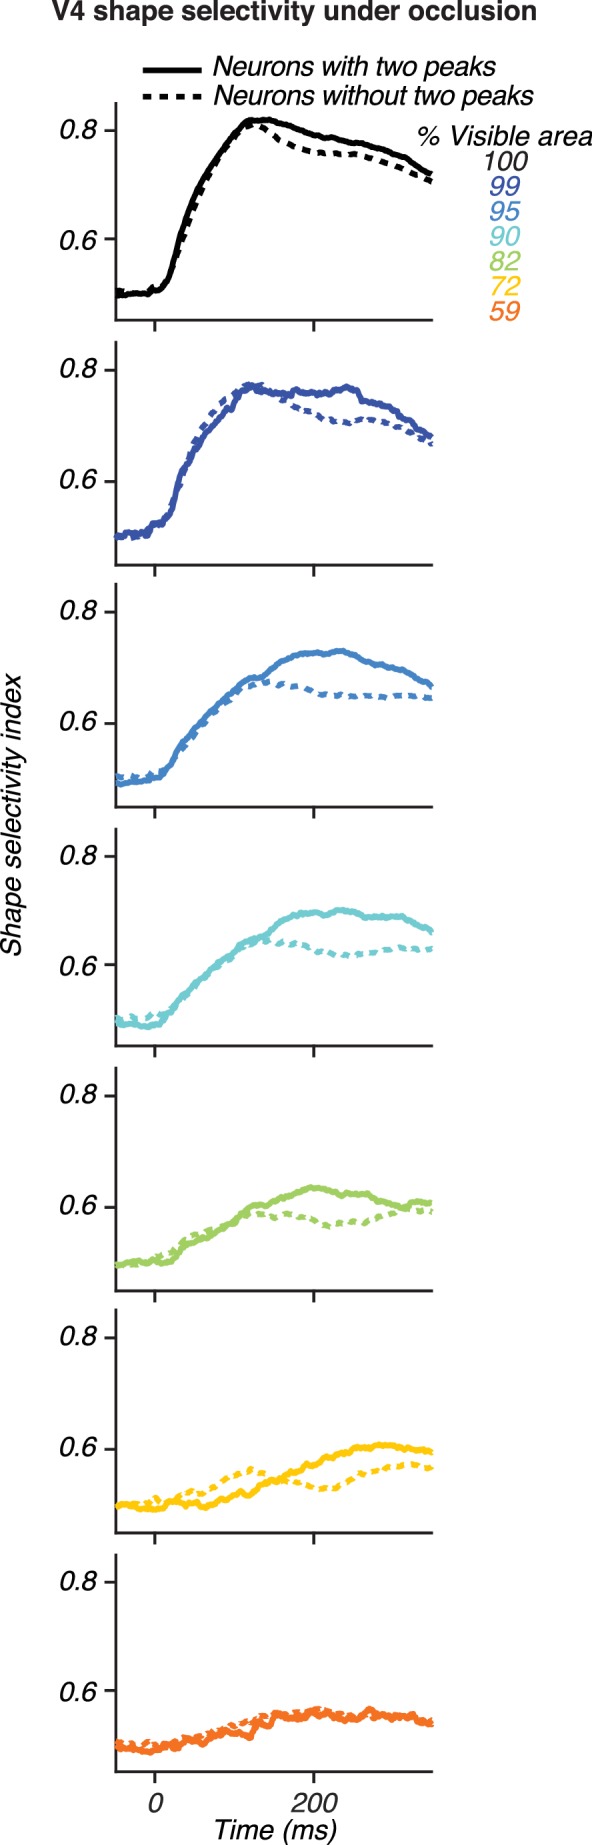
Comparison of shape selectivity under occlusion for V4 neurons with and without two peaks.Each panel shows shape selectivity as a function of time for unoccluded stimuli (black) and for stimuli at different occlusion levels (colors). Data are shown separately for neurons with (solid) and without (dashed) two peaks. At intermediate occlusion levels (blue to yellow), shape selectivity was stronger and reached a maximal value later for V4 neurons with two peaks, close to the median of second peak times (~214 ms). These data are as in Figure 8A–B, and replotted to facilitate direct comparison between neuronal groups.